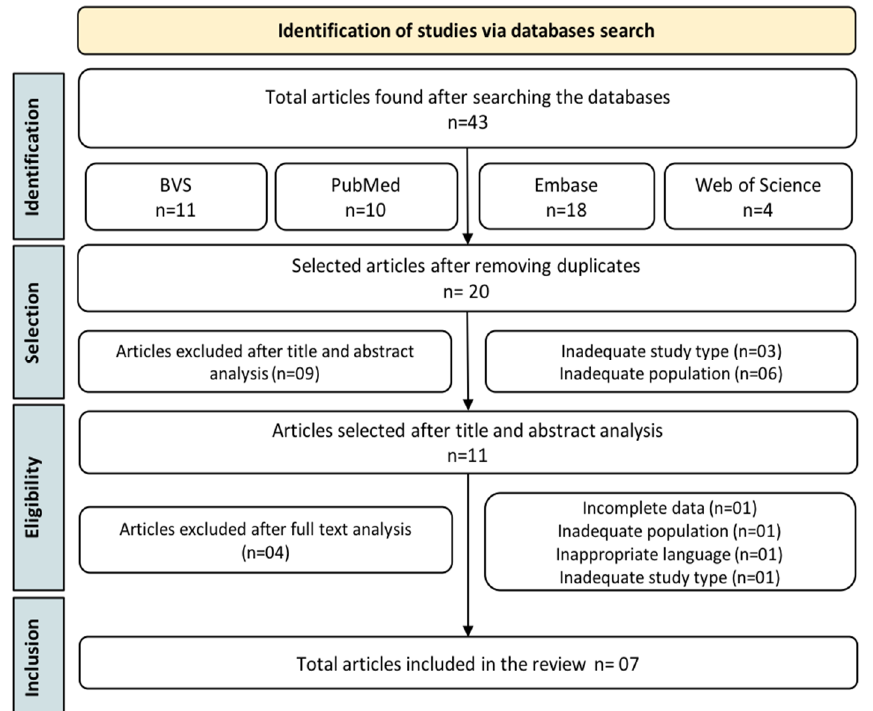
Figure 1. Flowchart outlining the steps adopted in the articles’ selection. Table 1. The comparison of different populational studies that investigated the MAOA uVNTR polymorphism associated with Major Depression Disorder (MDD).